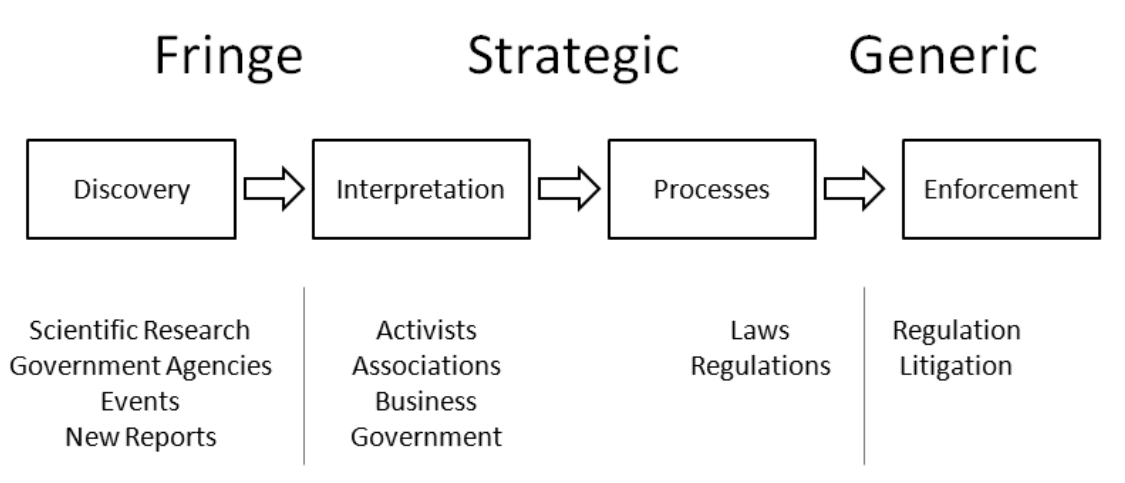
Figure 8: Tactical Levels on the Sustainability Frontier